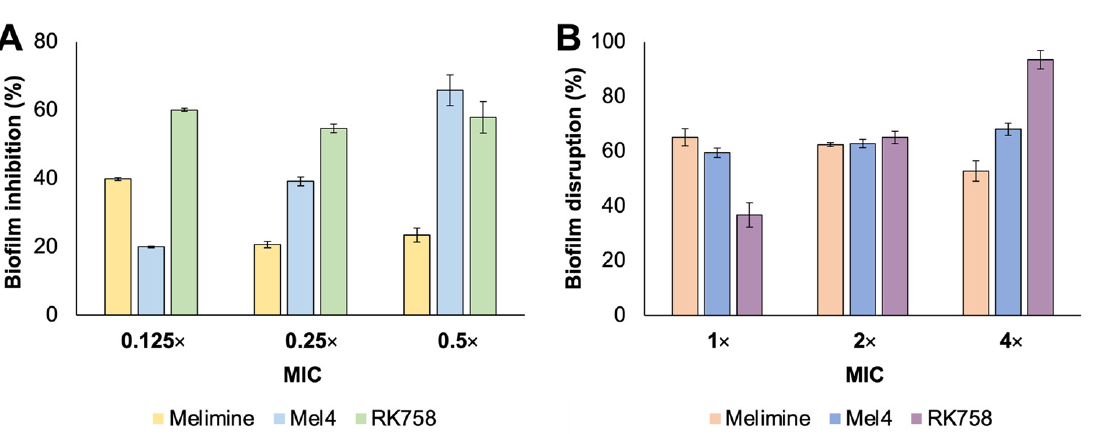
Figure 1. Activity of peptidomimetics against Staphylococcus aureus 38 biofilms. ( A ) Biofilm inhibition when peptidomimetics are used at sub-MIC. ( B ) Disruption of pre-formed biofilms when peptidomimetics are used ≥ MIC. Data represent mean ± SD, n = 2. MIC = minimum inhibitory